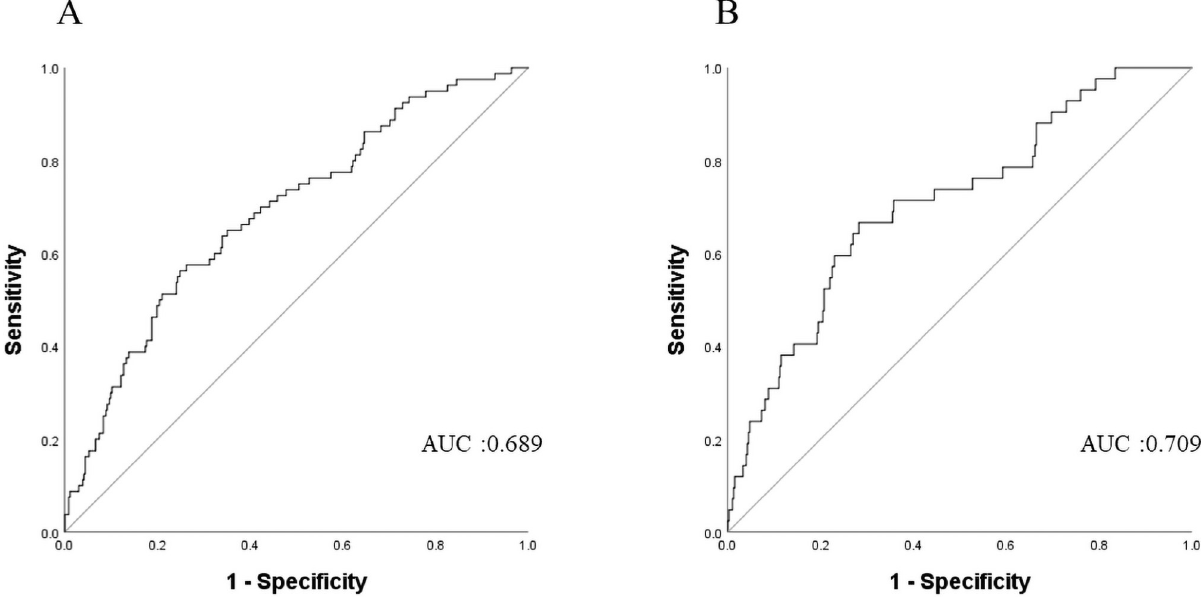
Fig 1. Clinical implications of SII in endometrial cancer patients. A. ROC curves for progression-free survival (PFS) at 3-years. B, ROC curves for overall survival (OS) at 3-years.